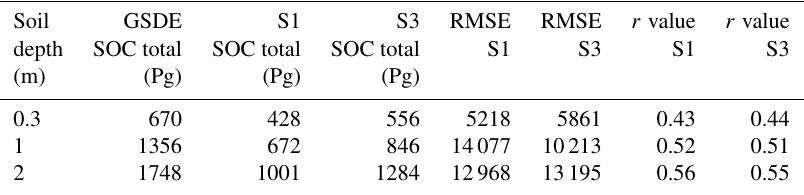
Table 5. Statistics of a grid cell by grid cell comparison of global SOC stocks between GSDE soil database and simulations S1 (with erosion) and S3 (without erosion). RMSE is the root mean square error and r value is the correlation coefficient of the linear regression between GSDE and S1 or S3. Soil